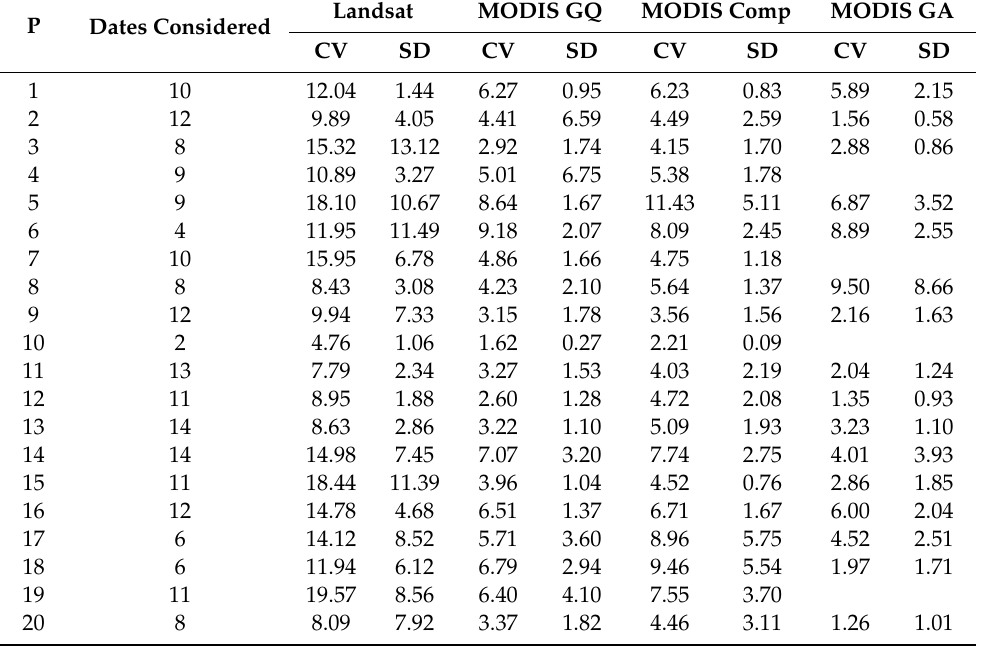
Table 6. Average of the coe ffi cient of variation (CV) of satellite information within paddocks on the considered dates and the standard deviation (SD) of those estimations for every paddock (P). P Dates